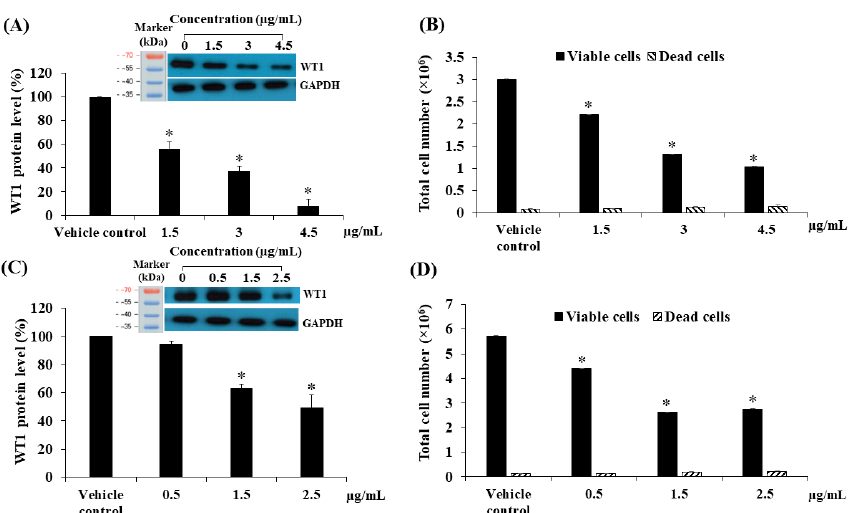
Figure 10. Effect of F-EtOAc and compound 1 at various concentrations on KG-1a cells. ( A ) The level of WT1 protein following treatment with F-EtOAc for 48 h. Protein levels were evaluated using western blot and analysed using a scanning densitometer. The levels of WT1 were normalised using GAPDH protein levels. ( B ) Total cell number following treatment with F-EtOAc for 48 h. Total cell numbers were determined via the trypan blue exclusion method. ( C ) The level of WT1 protein after treatment with compound 1 for 72 h. Protein levels were evaluated using Western blotting and analysed using a scanning densitometer. The levels of WT1 were normalised using GAPDH protein levels. ( D ) Total cell number following treatment with compound 1 for 72 h. Total cell numbers were determined via the trypan blue exclusion method. Each bar represented mean ± SD of three independent experiments performed in triplicate. Asterisks (*) denote significant differences from the vehicle control (* p < 0.01).